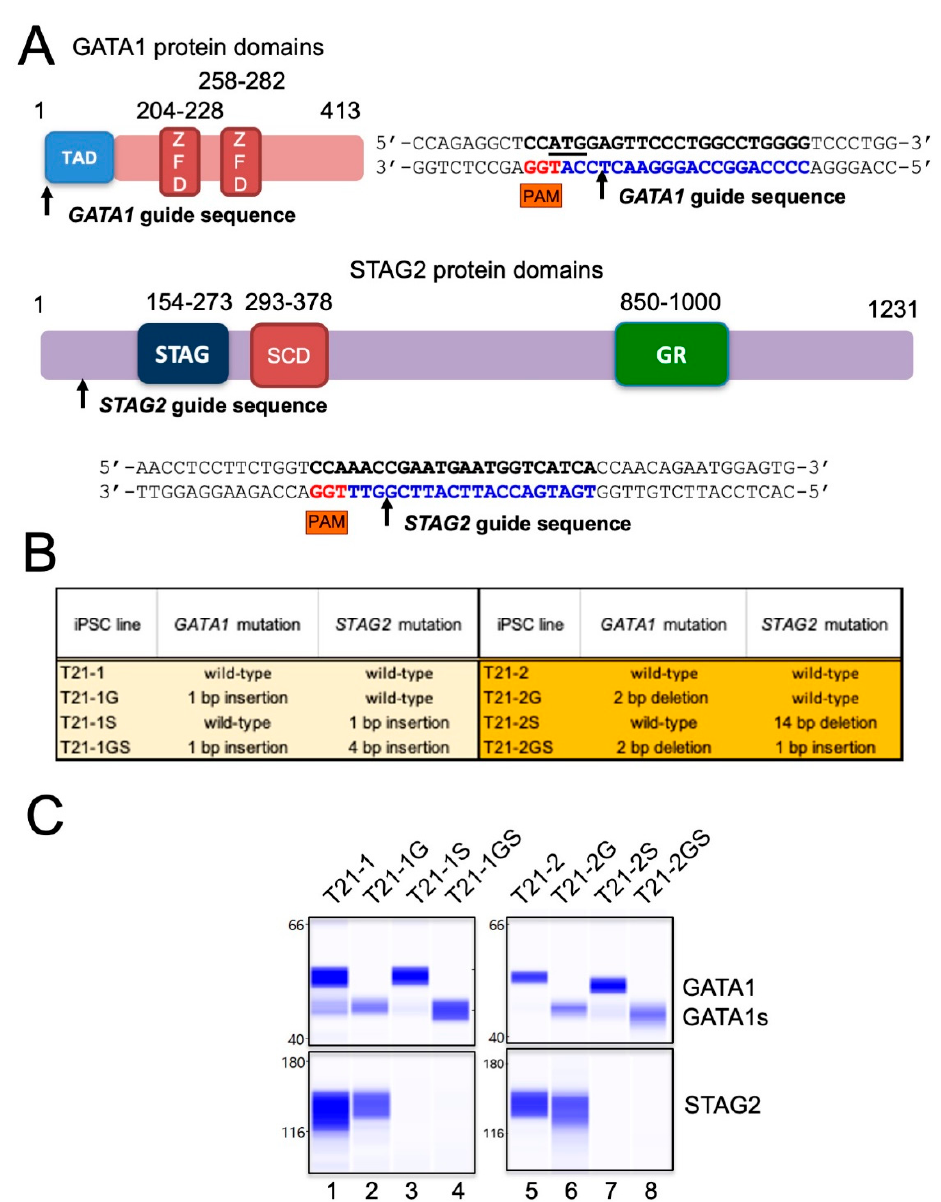
Figure 1. ( A ) Diagrammatic representation showing GATA1 protein domain organization containing two zinc finger domains (ZFD) and a N-terminal transcription activation domain (TAD). Arrow indicates the position of the cut site within the CRISPR guide sequence located in exon 1. Diagrammatic representation showing STAG2 protein domain organization containing STAG domain, stromalin conservative domain (SCD), and glutamine-rich (GR) domain. Arrow indicates the position of the cut site within the CRISPR guide sequence located in exon 5. ( B ) List of GATA1 and/or STAG2 mutant iPSC lines generated for the study. Isogenic lines are highlighted by the same color. ( C ) Immunoblots using the automated Western blotting system Wes in band view showing the GATA1, GATA1s, and STAG2. Total protein quantitation was performed to ensure equal